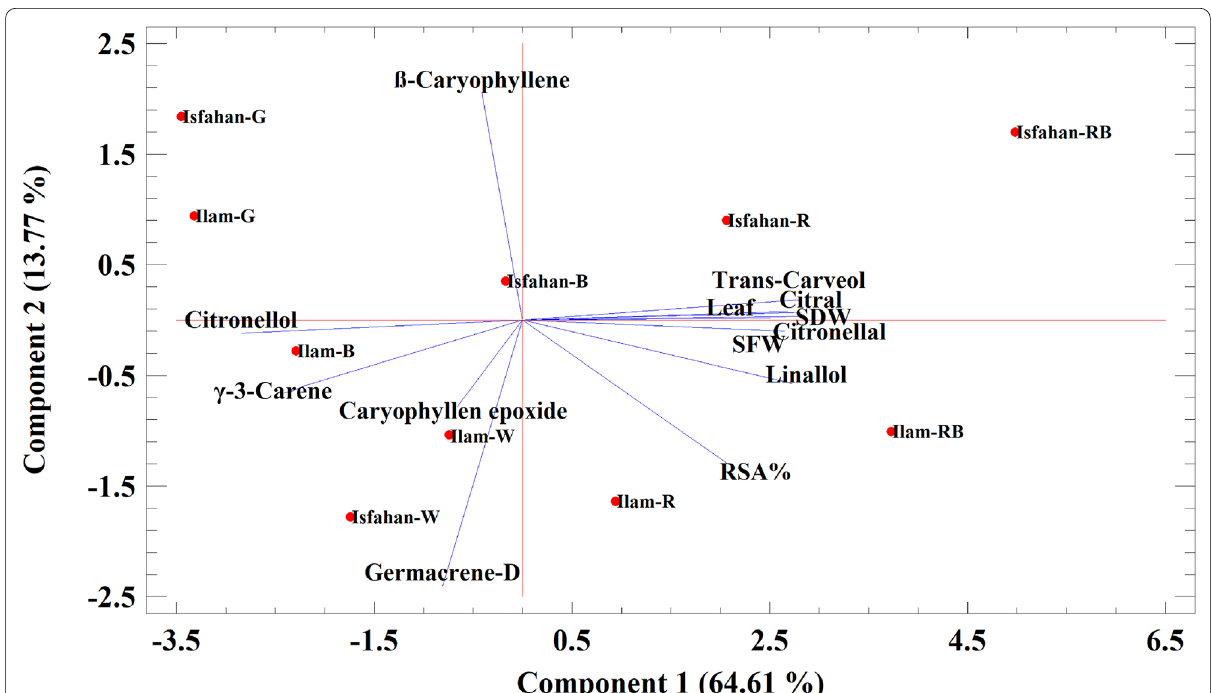
Fig. 2 Principal component analysis (PCA) for essential oil components, antioxidant activity, and different wavelengths applied on two genotypes of lemon balm. Ilam-W genotype Ilam-White LED, Ilam-RB genotype Ilam-Red LED, Ilam-G genotype Ilam-Greenhouse, Isfahan-W genotype Isfahan-White LED, Isfahan-RB genotype Isfahan-Red Isfahan-Red LED, Isfahan-B genotype Isfahan-Blue LED, Isfahan-G genotype Isfahan-Greenhouse, RSA% radical scavenging activity (%), SFW shoot fresh weight, SDW shoot dry weight, Leaf leaf